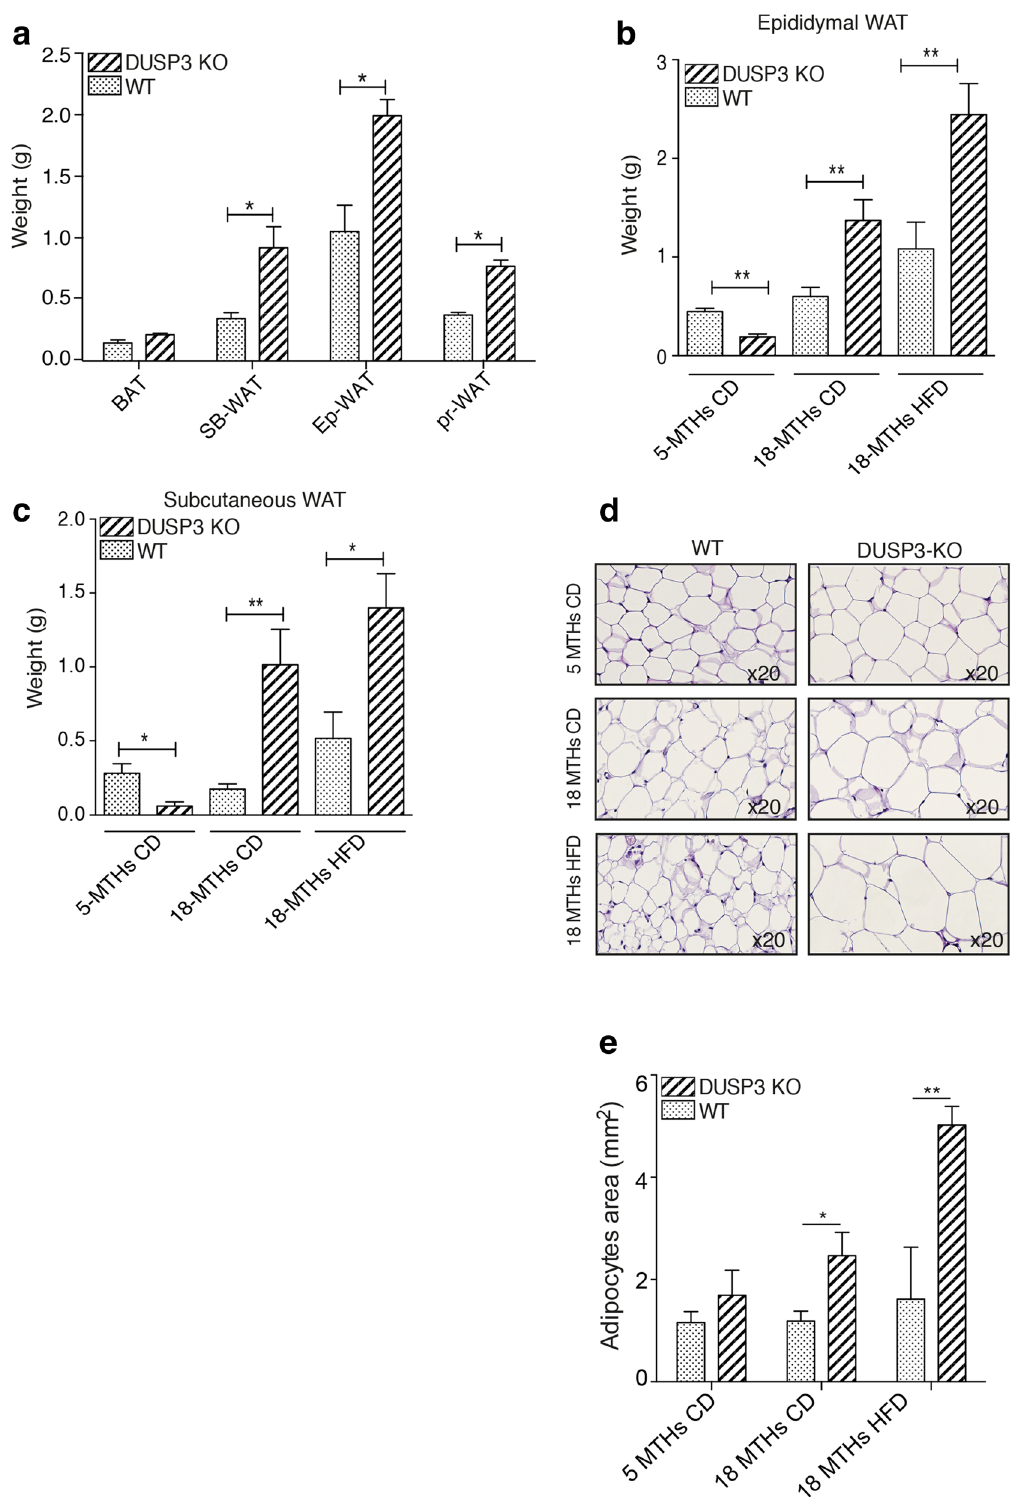
Figure 2. DUSP3 deletion promotes white adipose tissue accumulation. ( a ) White and brown adipose tissue (WAT and BAT, respectively) was assessed in 18-month-old WT and DUSP3-KO mice. SB subcutaneous, Ep epididymal and Pr perirenal. ( b , c ) Subcutaneous and epididymal fat assessment in 5-month-old WT and KO mice under CD and in 18-month-old WT and KO mice under CD and HFD. ( d ) Representative paraffin sections of epididymal WAT from 5-month-old WT and DUSP3-KO mice under CD and at 18-month-old under CD and HFD. Sections were stained with H&E. Magnification: ×20. ( e ) Average adipocytes cell area of epididymal WAT of the mice shown in ( d ). Data represent the mean ± SD of at least three mice of each group (*P < 0.5; **P <